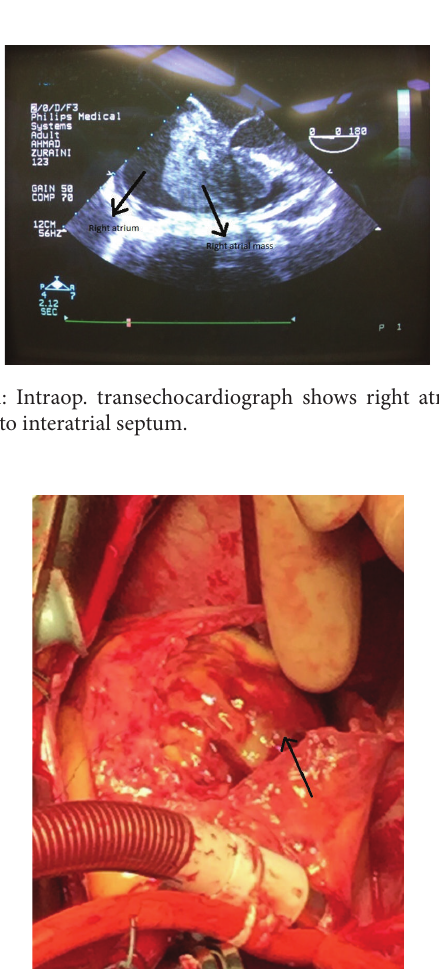
the interatrial septum. On palpation, there was thickening of interatrial septum just above the right ventricle. Trans- esophageal echocardiogram confirmed the finding (Figure